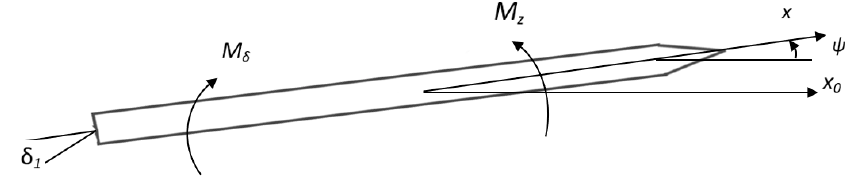
Figure 2. Action control and disturbing moments.